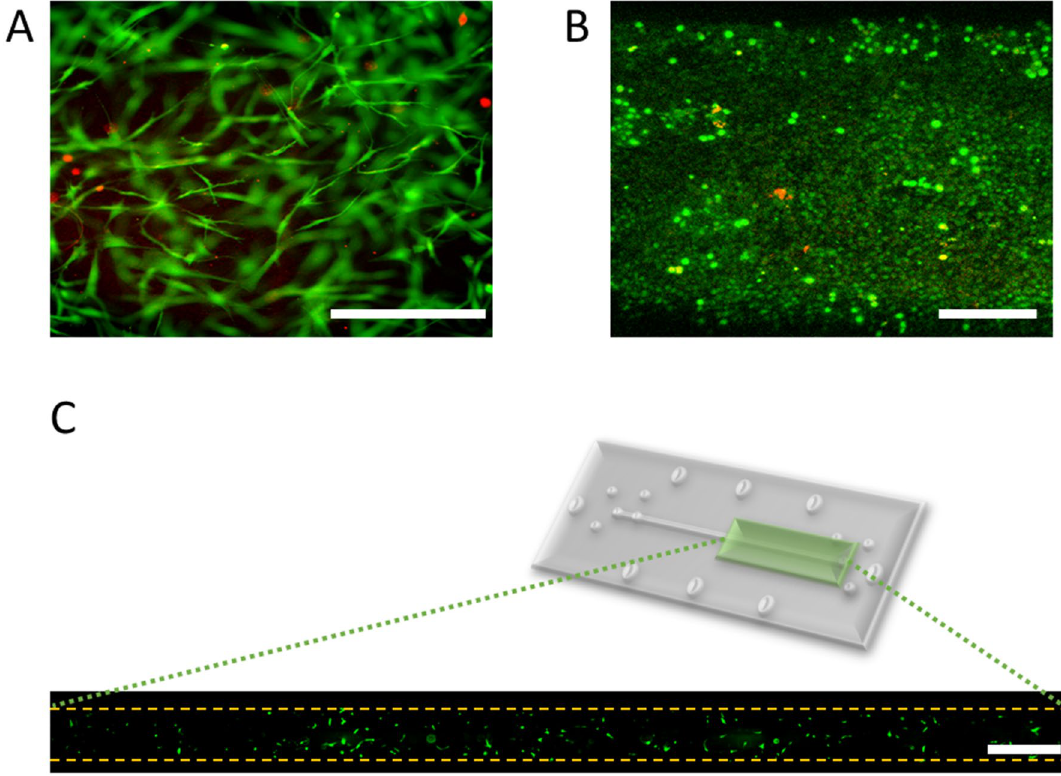
Figure 8. Live/Dead assay in the microfluidic chip. Green and red fluorescence denote live and dead cell, respectively ( A ) hFBs inside of the fibrin hydrogel 4 days after loading in the channel. Scale bar: 100 µm. ( B ) hKCs after 4 days after seeding on top of the fibrin hydrogel. Scale bar: 200 µm. The figures are maximum intensity projections from z-stacks obtained with confocal microscopy. ( C ) Top view of the UC 24 h after loading a fibrin hydrogel containing GFP-hFBs using the parallel flow method. The upper figure indicates the region of the UC that is presented enlarged in the lower figure. GFP-hFBs are homogeneously distributed along the chamber and display a spindle shape, indicating that they are well spread. Scale bar: 1000 µm.